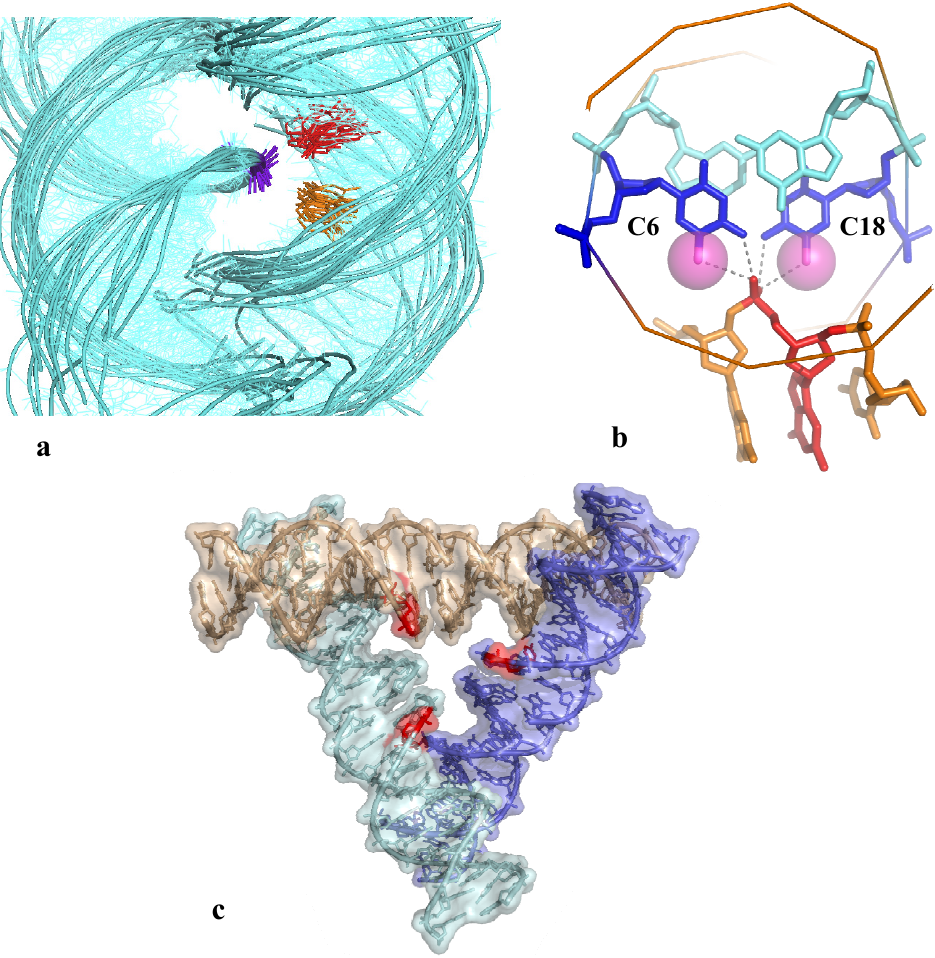
Figure 3. Cytosine and DNA self-assembly. ( a ) Superimposed self-fitted right-handed DNA crossovers found in the Nucleic Acids Database. The cytosines involved in the interaction are represented in red and orange; ( b ) 5-Methyl cytosine stabilizes the groove-backbone interaction through the formation of C–H…O interactions with the phosphate group; ( c ) The role of the sequence in DNA self-assembly: the cytosines (represented in red) dictate the organisation of the triangular motifs.